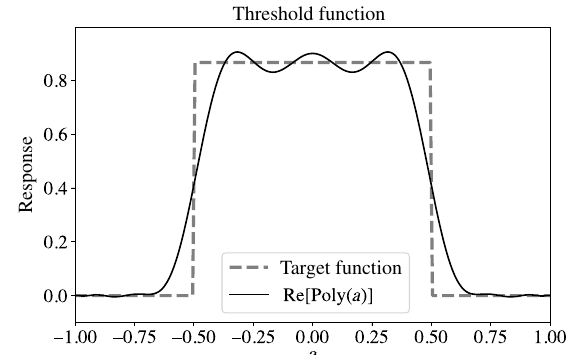
FIG. 25. The response function for the polynomial approxima- tion to the threshold function with k = 10 and d = 18.